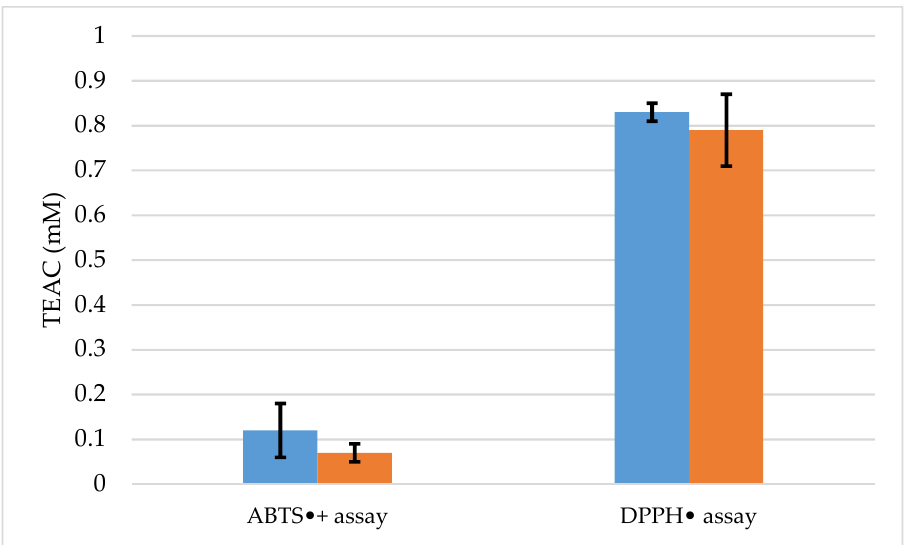
Figure 1. ABTS •+ and DPPH • radical scavenging assay e Trolox equivalent antioxidant capacity de Calycolpus goetheanus . Values are expressed as mean and standard deviation ( n = 3) of Trolox equivalent antioxidant capacity. The ABTS • + and DPPH • Radical Scavenging Assay (ABTS • + ; DPPH • )